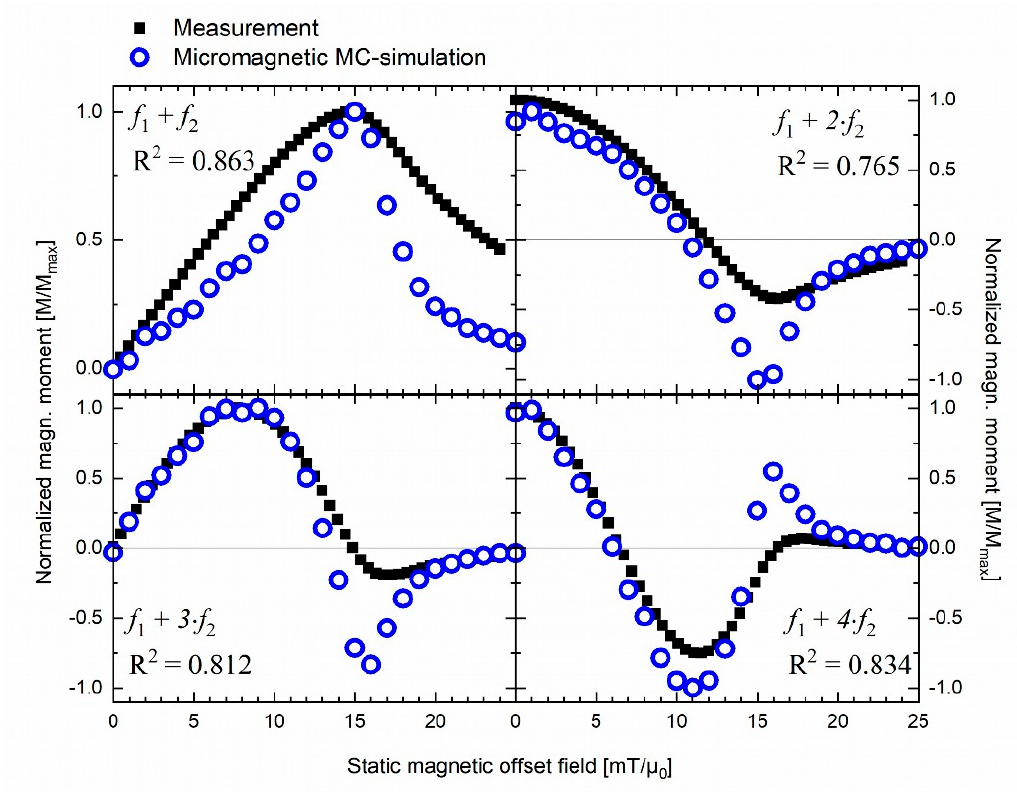
Figure 3. Normalized MNP nonlinear magnetic moment for dual frequency excitation at mixing frequencies f 1 + n · f 2 with n = 1,2,3,4 comparing experimental results ( H 1 = 1.29 mT/ µ 0 , f 1 = 30,534 Hz, H 2 = 16.4 mT/ µ 0 , f 2 = 62.95 Hz) and predictions from micromagnetic MC-simulations ( H 1 = 1 mT/ µ 0, f 1 = 40,000 Hz, H 2 = 16 mT/ µ 0 , f 2 = 2000 Hz).